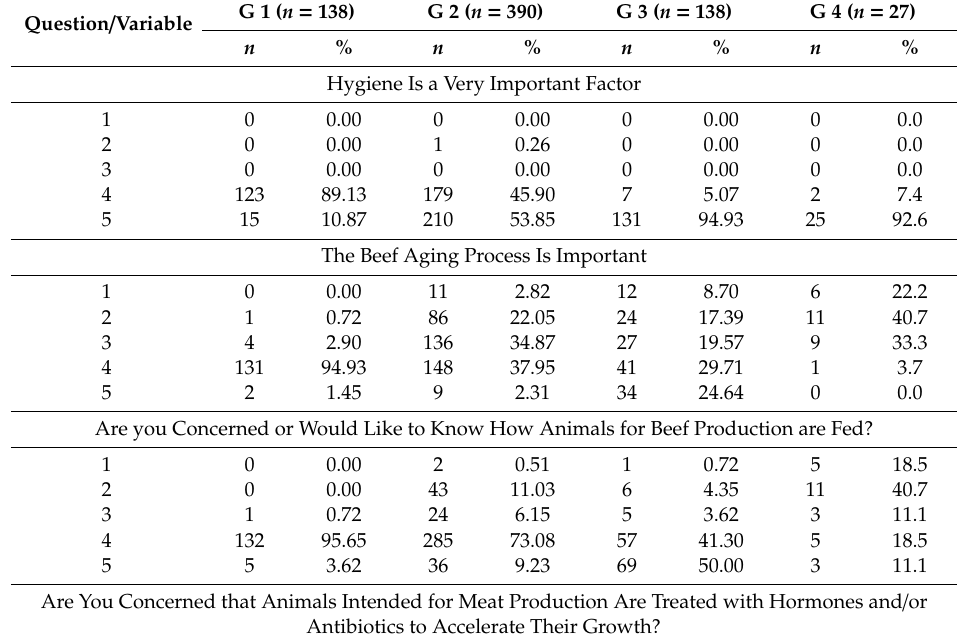
Table 5. Extrinsic attributes with significant di ff erences ( p < 0.05 *) in the groups of consumers identified by cluster